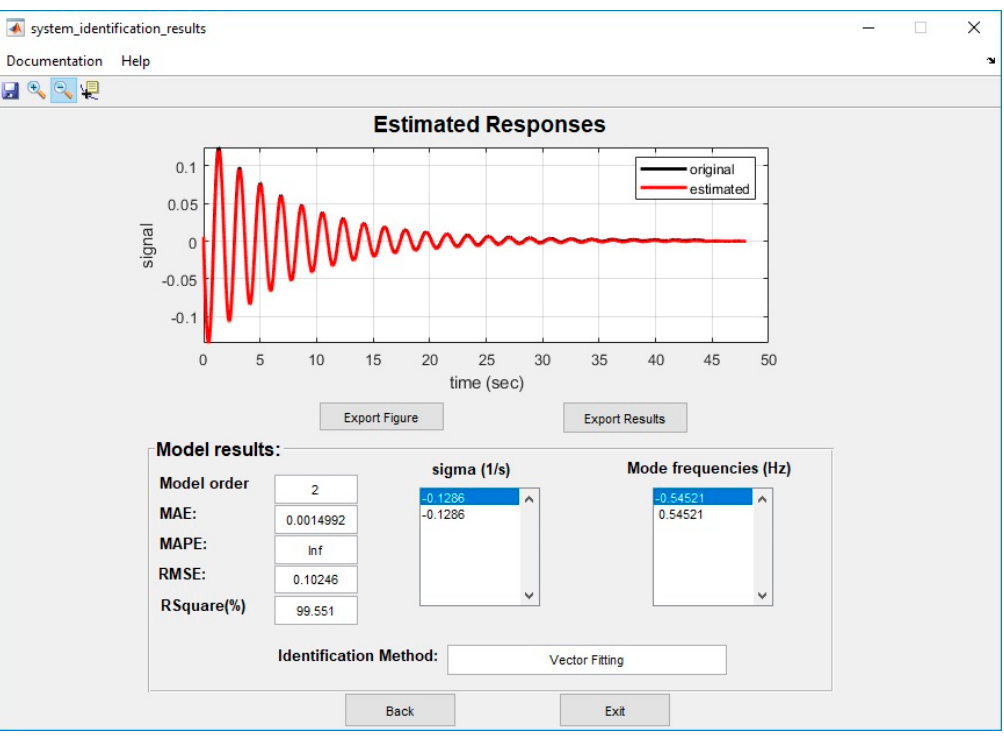
Figure 6. Mode identification result window. Indicative results for single signal analysis and predetermined model order.